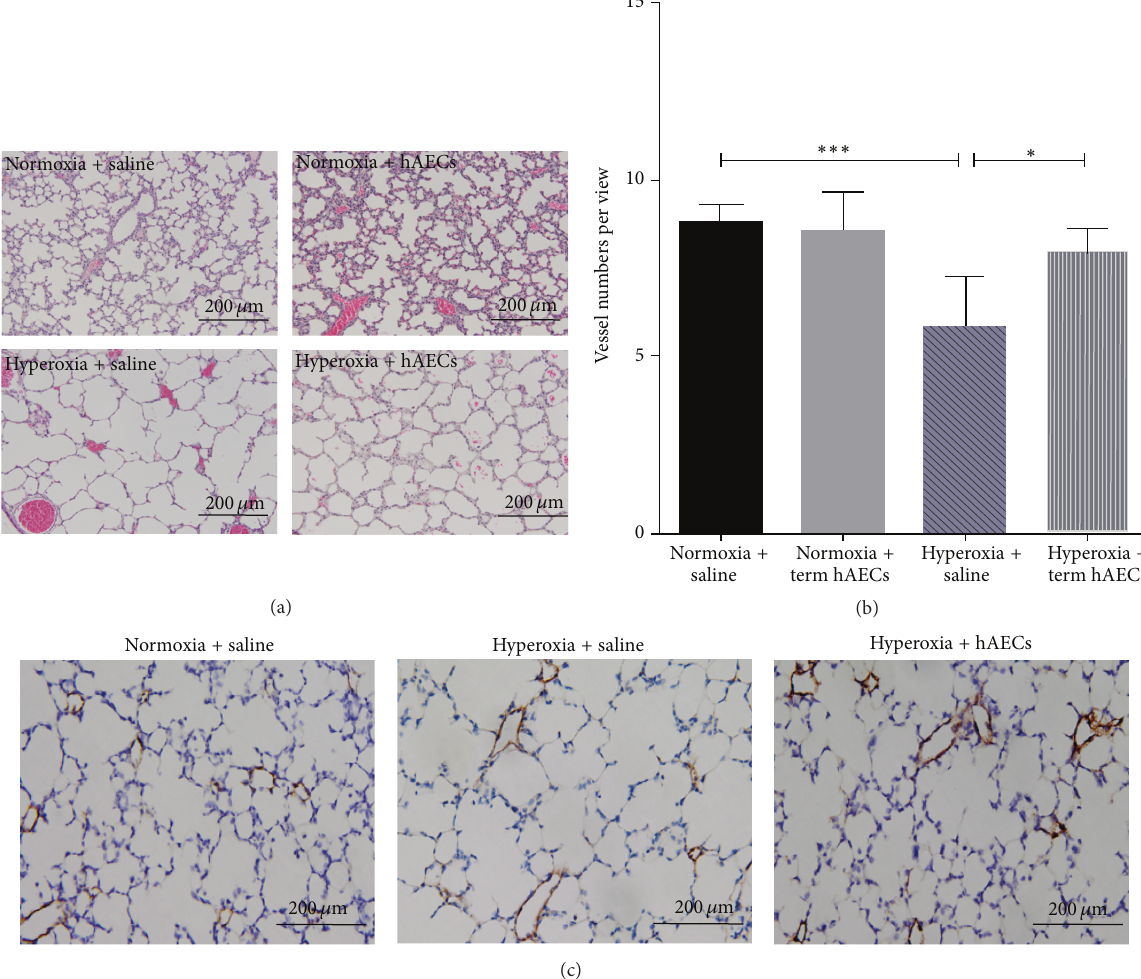
Figure 7: H&E staining and vWF immunohistochemistry in neonatal mouse lung tissue. (a) Hyperoxia-induced lung injury mice had simplified lung structure and enlarged alveoli, and term hAEC treatment improved lung structure. (b) The number of vessels (diameter < 50 𝜇 m) decreased in hyperoxia-injured animals compared with normoxia animals ( 𝑝 < 0.001 ). Term hAEC administration restored the number of small pulmonary vessels in hyperoxia-induced lung injury animals ( 𝑝 < 0.05 ). (c) The representative images for vWF immunohistochemistry in mouse lung tissues ( ∗ 𝑝 < 0.05 , ∗∗∗ 𝑝 < 0.001